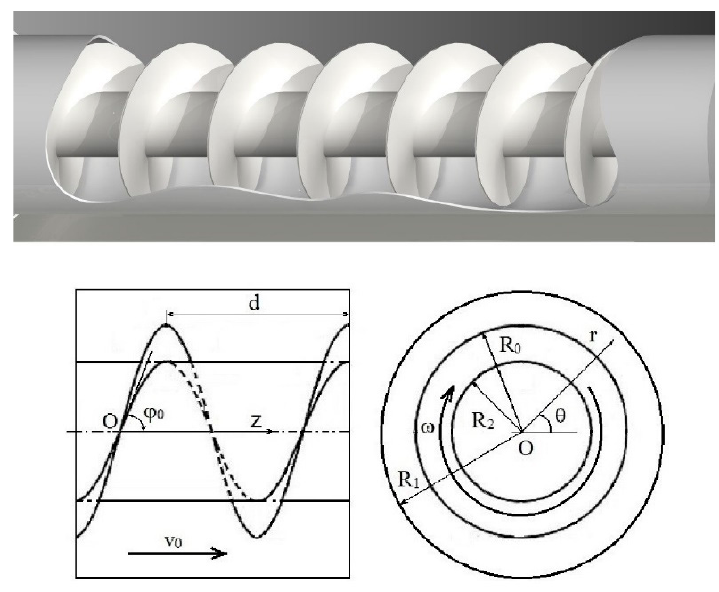
Figure 1. The scheme of the auger with a shaft and the sizes of its section.